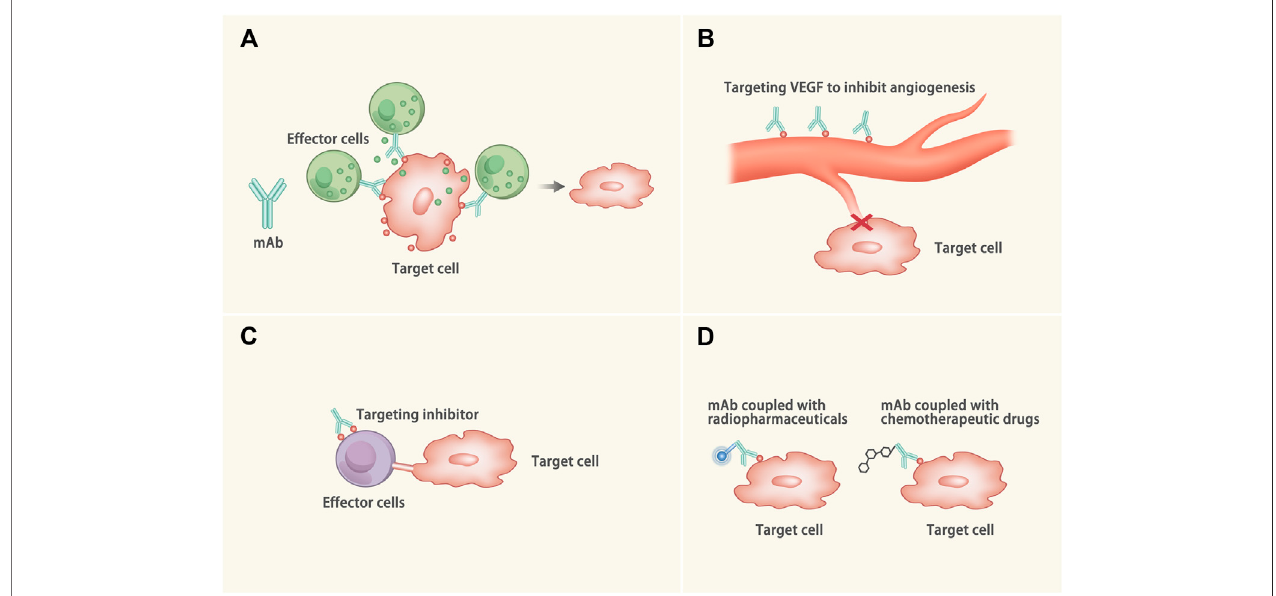
FIGURE 1 | Mechanisms of the mAb. (A) The Fab of the mAb binds to the target epitope and the Fc of the mAb binds to the effector cell (such as the natural killer cell) or the complement to kill the target cells through antibody-dependent cell-mediated cytotoxicity, complement-mediated cytotoxicity or directly inhibit abnormal signalsofthetarget cells. (B) ThemAbbindstothegrowthfactor (suchasVEGF)toinhibittheangiogenesisofthetargetcells. (C) Theinteractionbetweensomeligands andreceptors(suchasPD-1/PD-L1)caninactivatetheeffectorcells.ThemAbbindstotheinhibitorymoleculetoprotecttheeffectorcellsfromdysfunction. (D) The mAbs are equipped with radiopharmaceuticals or chemotherapeutic drugs. When the mAbs binds to the target cells, the drugs come close to the target cell and kill the target cells.